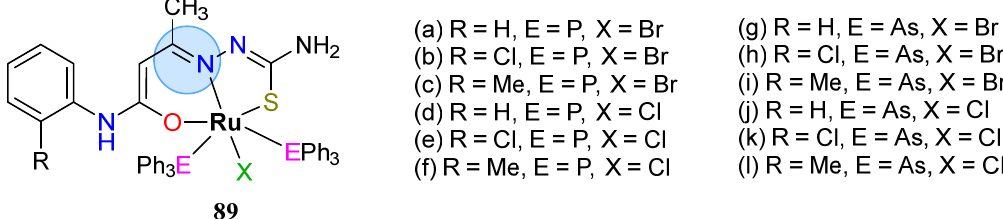
Figure 46. Ruthenium(III) complexes containing dibasic tridentate Schiff bases with antibacterial activity.